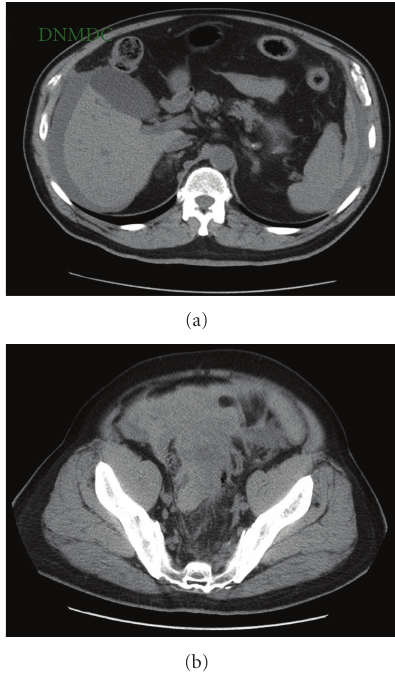
Figure 1: Preoperative computed tomography scan of the abdomen showing extensive hemoperitoneum (a) below the spleen and liver, among the small bowel, (b) in the left and right paracolic gutter, in front of the urinary bladder with a distended rectum.